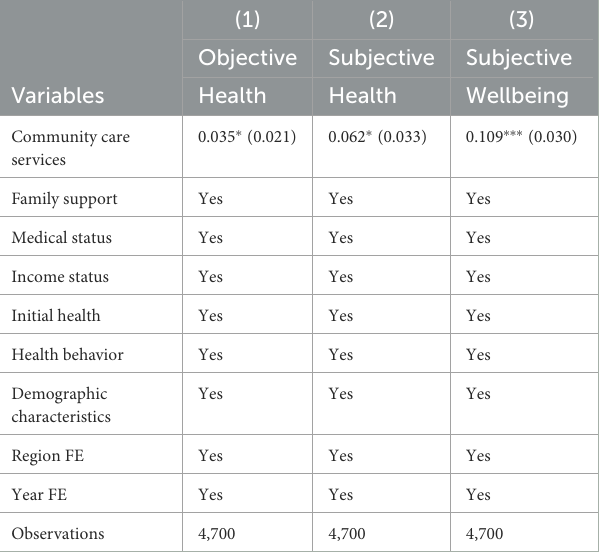
TABLE 2 OLS estimation results for community care services and the health of older